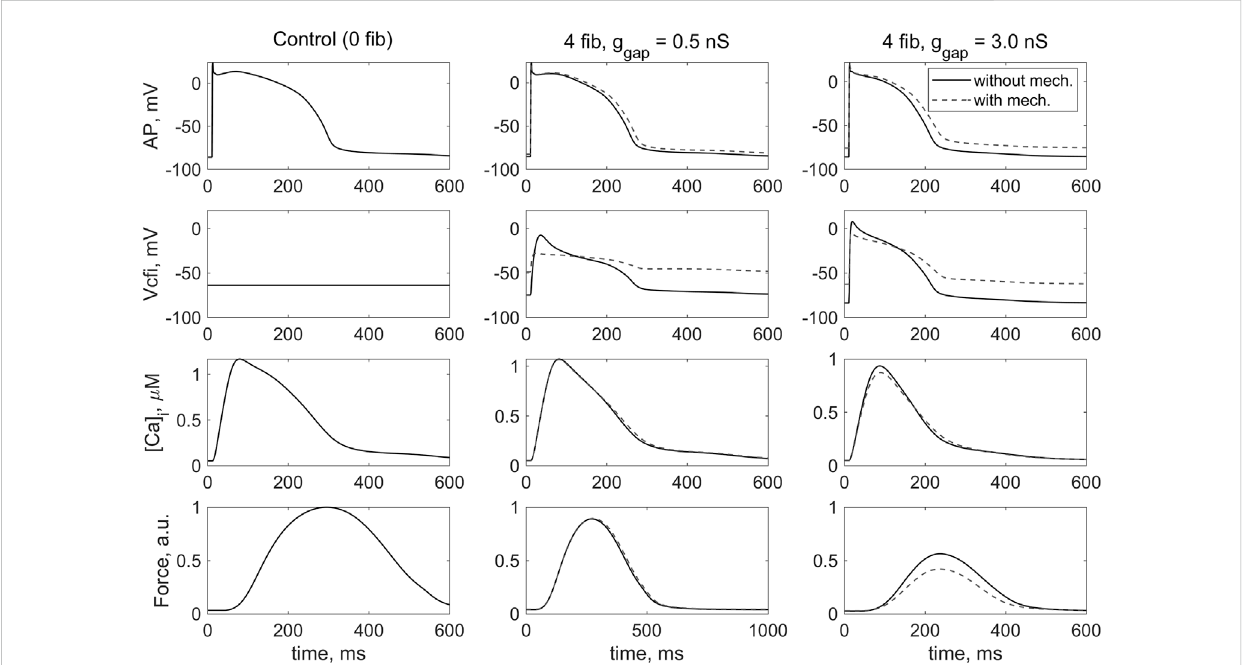
FIGURE 3 Simulationoftheeffectofcoupled fi broblasts( n =0,4)anddifferentvaluesofintercellular fi broblast-to-myocyteconductance( ɡ gap =0.5,3.0 nS)in steady-stateisometriccontractionsonthecardiomyocyteactionpotential( AP ),themembranepotentialacrossthe i -thcoupled fi broblast ( V c fi ),theCa 2+ transient ( [Ca] i ) and the active force generated by the cardiomyocytes ( Force ). The left column contains the results of the simulation of the isometric contractionofthesamevirtualsinglecardiomyocyterepresentedby TP+M model.Inthiscase,themembranepotentialoftheuncoupled fi broblast is shown. The simulation in model 1 ( “ without mech ” ) and model 2 ( “ with mech ” ) are compared in the middle and left rows. The stimulation frequency is 1 Hz. The force values are normalized to the peak isometric force of the uncoupled